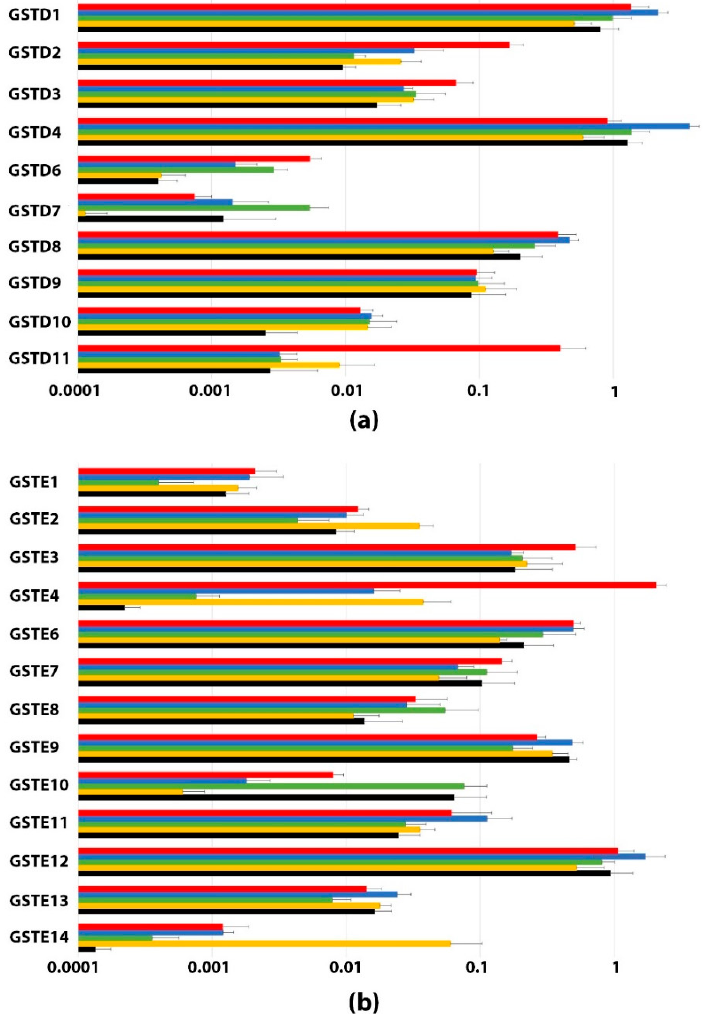
Figure 3. Expression levels of Delta and Epsilon GSTs from D. melanogaster in various tissues. ( a ) GST Delta and ( b ) GST Epsilon. qRT-PCR was performed on olfactory organs (antennae and maxillary palps in red), taste organs (labellum in blue), the gut in green, the head in yellow (without chemosensory appendages) and the carcass in black for GST Delta ( a ) and GST Epsilon ( b ). All data corresponding to the normalized expression level are plotted as the mean ± SD of triplicate biological samples on a log scale.